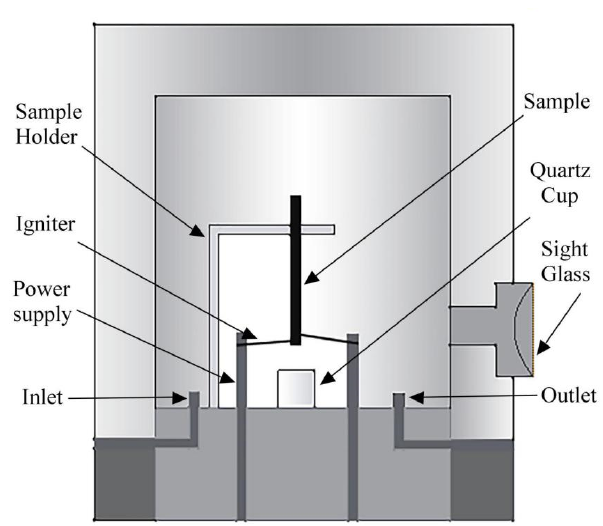
Figure 3. Diagram of promoted combustion test facility, reproduced from [46] with permission from ASTM, 2020.